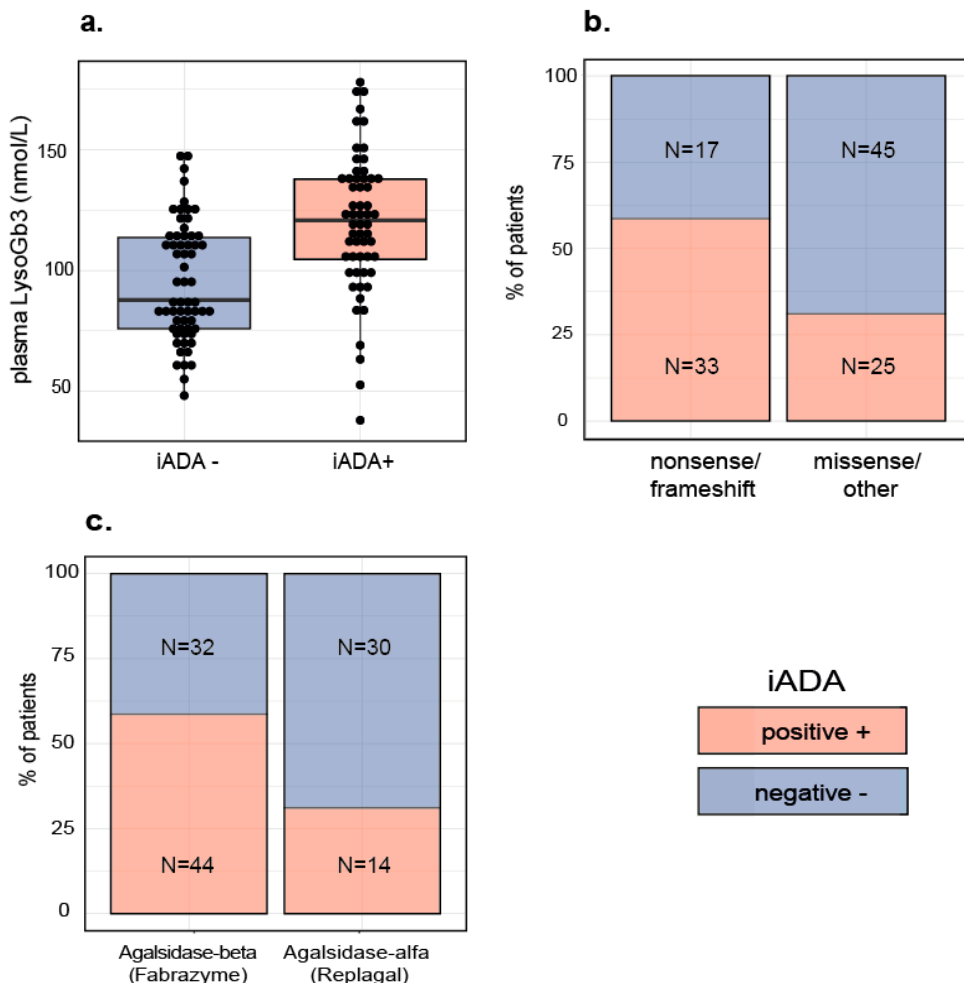
Figure 1. Distribution of variables significantly associated with an increased risk of iADA development in male Fabry patients with classical disease. Color represents iADA status. ( a ) Baseline plasma lysoGb3 levels. ( b ) Mutation type (n.b. eight out of 25 iADA positive patients in the missense group had a mutation at location c.1025). ( c ) Treatment type at start of treatment: agalsidase beta (0.2–1 mg/kg) versus agalsidase alfa (0.2 mg/kg).